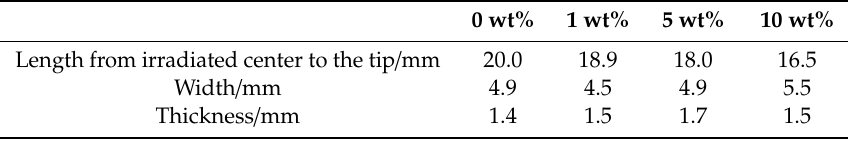
Table 2 . Sizes of silicone strips used for observations. Table 2. Sizes of silicone strips used for observations.